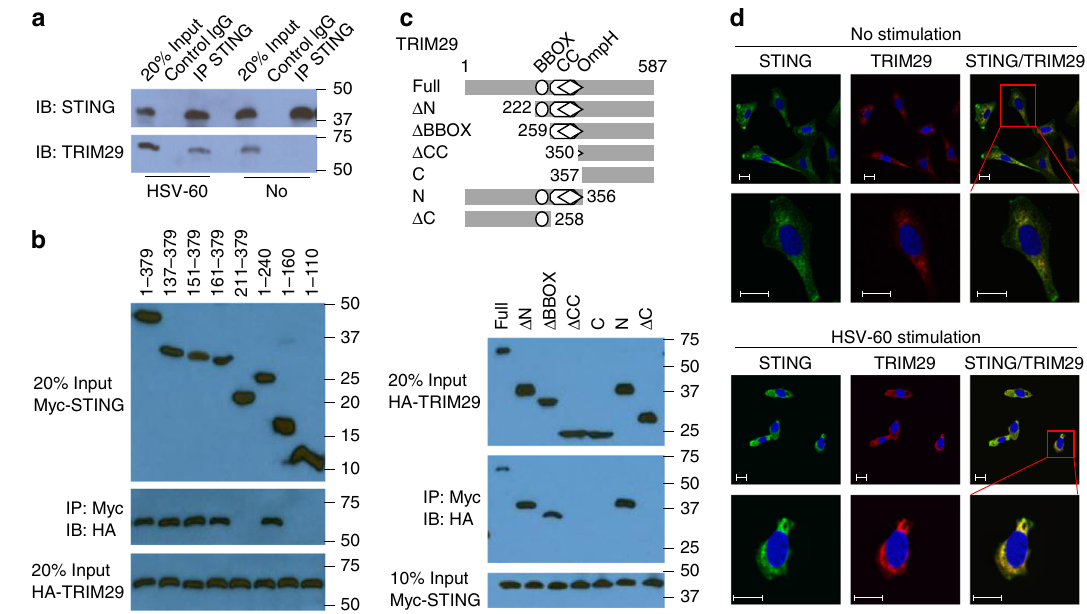
Fig. 6 TRIM29 binds and colocalizes with STING in the cytosol. a Immunoblot analysis of endogenous proteins of TRIM29 and STING precipitated with anti-STING or immunoglobulin G (IgG; control) from whole-cell lysates of BMDCs from WT mice stimulated without (No) or with HSV-60 (2.5 μ g/ml) for 8 h, and then with MG132 treatment for 3 h. Input, 20% of the BMDCs lysate. b Full-length STING and serial truncations of STING with deletion of various domains ( top ). Immunoblot analysis of puri fi ed HA-tagged TRIM29 with anti-HA ( bottom blot ), and immunoblot analysis of puri fi ed HA-tagged full-length TRIM29 with anti-HA ( middle blot ) or puri fi ed Myc-tagged full-length STING and STING truncation mutants alone with anti-Myc ( top blot ) after incubation with Myc-tagged full-length STING and STING truncation mutants and immunoprecipitation with anti-Myc ( top and middle blots ). c Full-length TRIM29 and serial truncations of TRIM29 with deletion ( Δ ) of various domains ( left margin ); numbers at ends indicate amino-acid positions ( top ). Below , immunoblot analysis of puri fi ed Myc-tagged STING with anti-Myc ( bottom blot ), and immunoblot analysis (with anti-HA) of puri fi ed HA-tagged full-length TRIM29 and TRIM29 truncation mutants alone ( top blot ) or after incubation with Myc-tagged STING and immunoprecipitation with anti-Myc ( middle blot ). d Colocalization of endogenous TRIM29 and STING in BEAS-2B cells. Confocal microscopy of BEAS-2B cells without stimulation, or stimulated with dsDNA HSV-60 for 4 h. STING was stained with Rabbit anti-STING polyclonal antibody (Cat: 19851-1-AP, Proteintech), followed by Alexa Fluor 488 goat anti-rabbit secondary antibody ( green ), while TRIM29 was stained with mouse anti-TRIM29 monoclonal antibody (sc-166707, Santa Cruz), followed by Alexa Fluor 594 goat anti-mouse secondary antibody ( red ). DAPI (4 ′ ,6-diamidino-2-phenylindole) served as the nuclei marker ( blue ). Scale bars represent 20 µ m. The position of protein markers (shown in kDa) is indicated on the right . Data are representative of three independent experiments